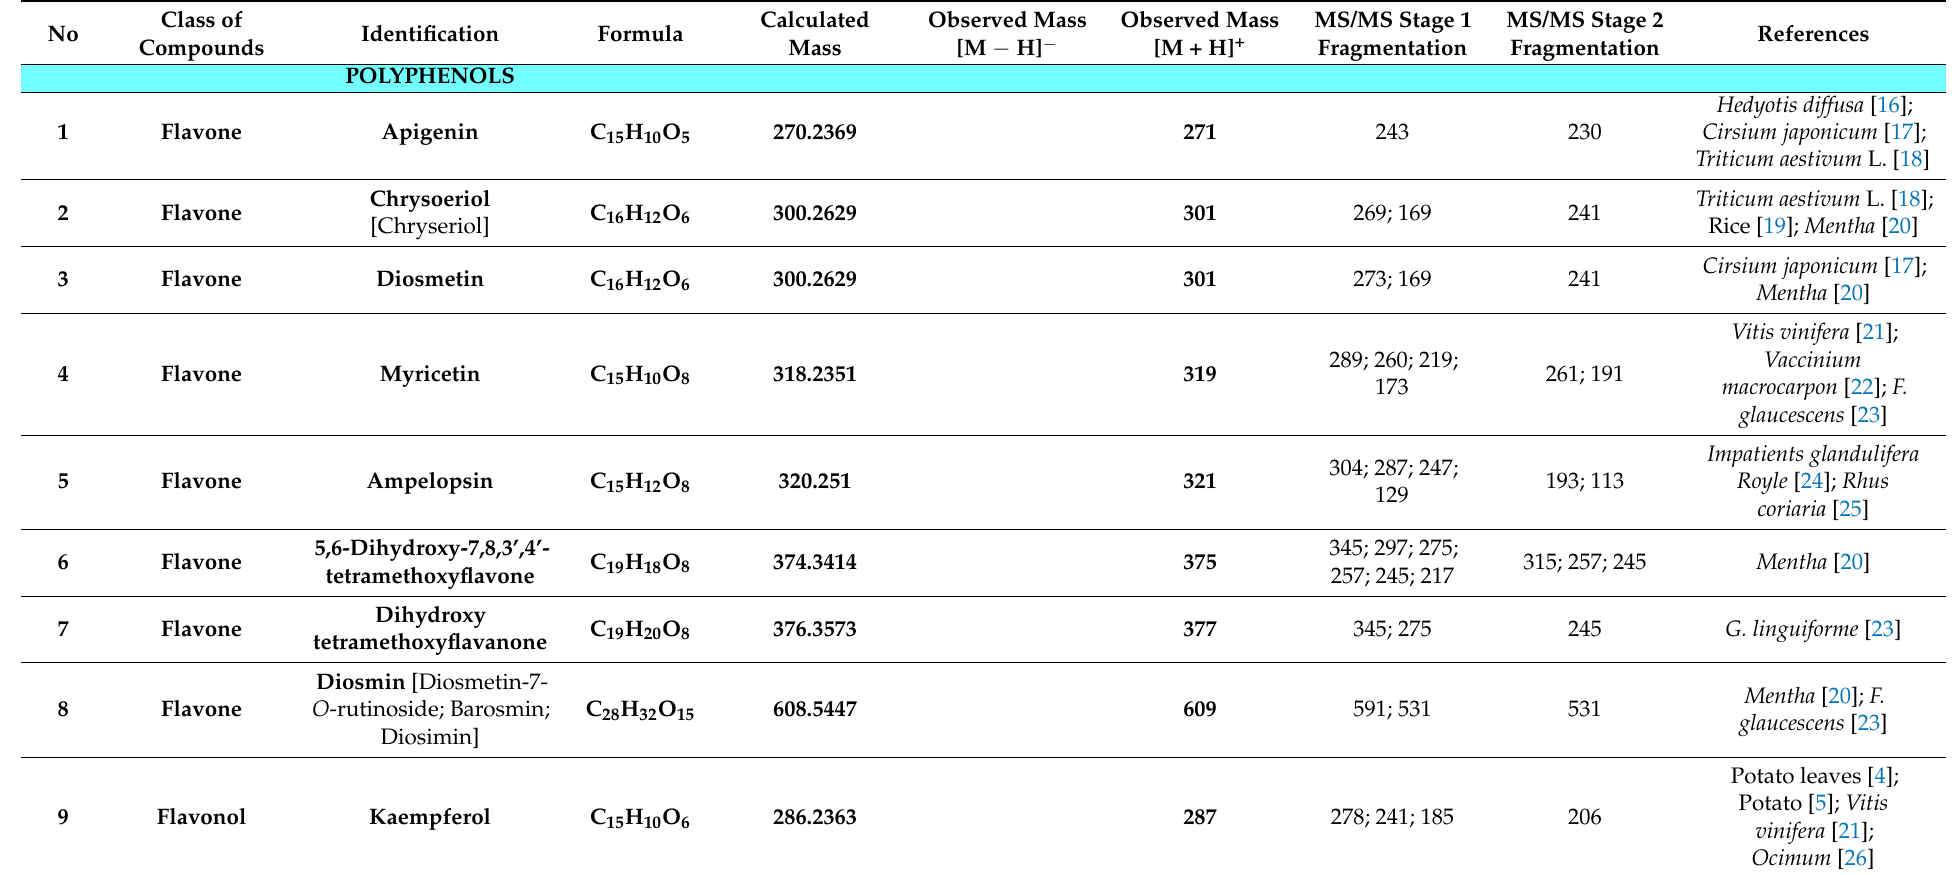
Table 1. The target analytes isolated from the MeOH-extract of S. tuberosum